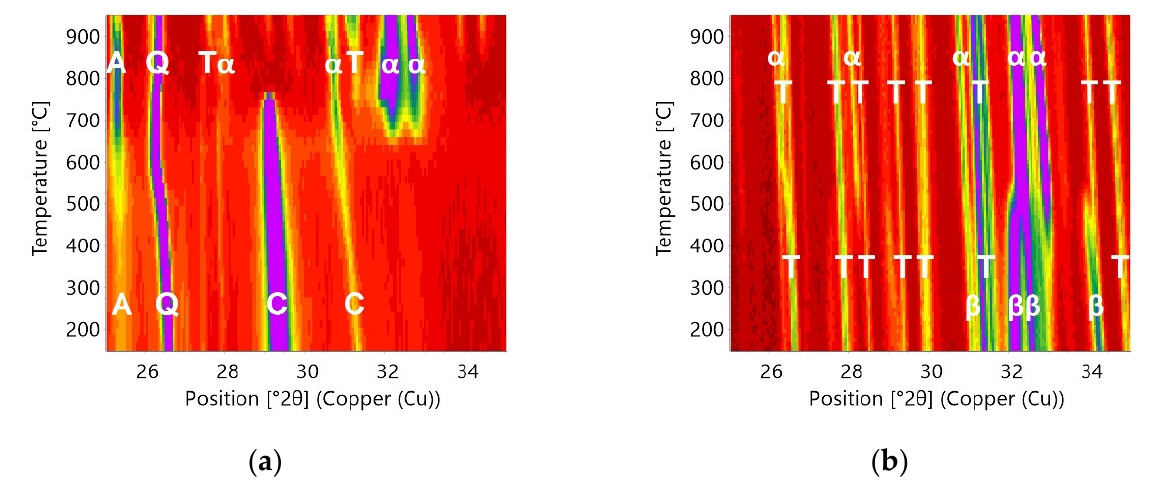
Figure 2. Isolines plot of the in situ X-ray diffraction measurements in HTK1200N: Heating ( a ) and cooling ( b ) of Sample D3 (step10). Main phases are marked at the lines as α - α ’H-C 2 S, β - β -C 2 S, A-anhydrite, Q-quartz, T-ternesite, C-calcite.